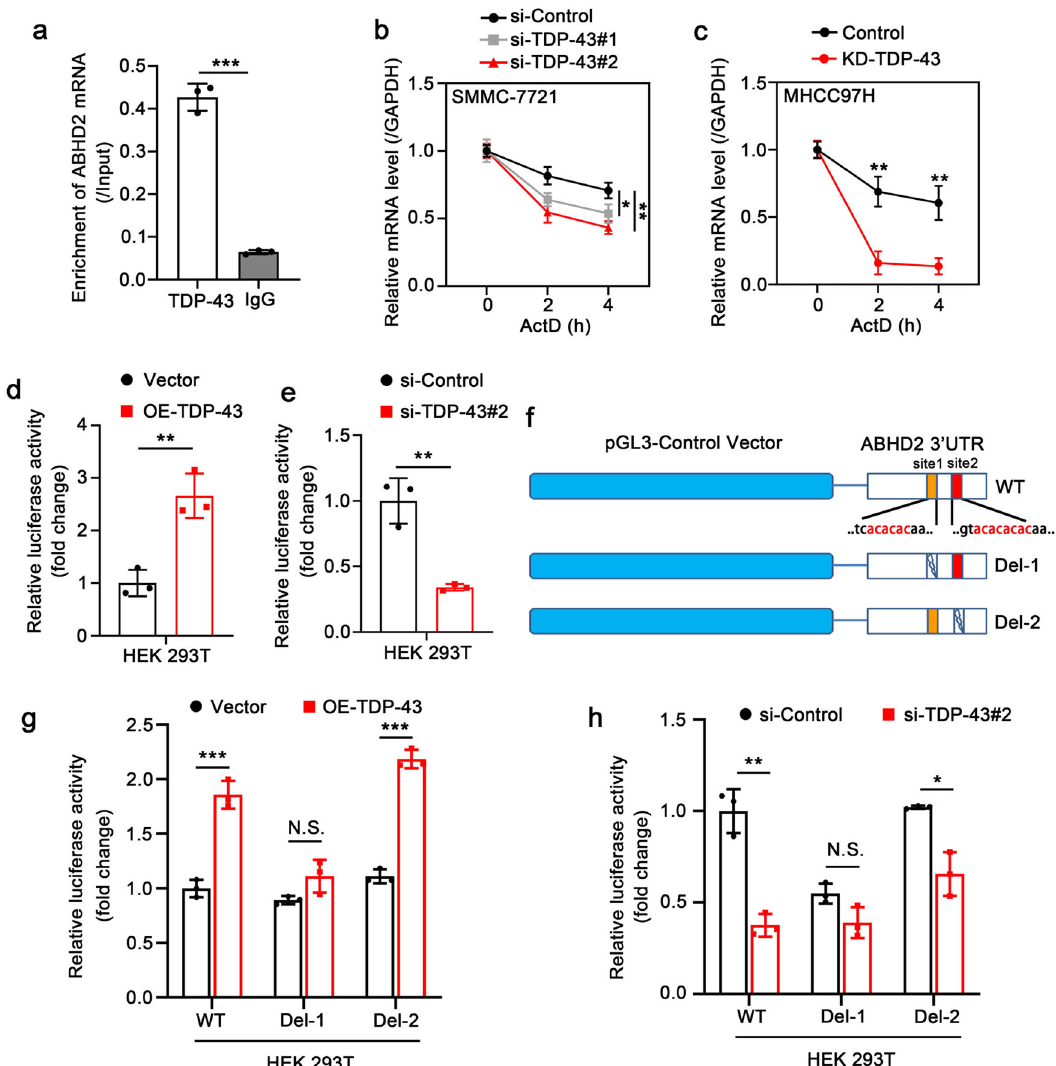
Fig. 5 TDP-43 upregulates ABHD2 through enhancing the mRNA stability of ABHD2. a RIP assay to detect the interaction between TDP-43 and ABHD2 mRNA in MHCC97H cells. The data was normalized to the Input. b The mRNA stability of ABHD2 was analyzed by qRT-PCR in SMMC-7721 cells upon TDP-43 deletion. The cells were treated with ActD for the indicated time points after transient transfection for the indicated siRNAs. c The mRNA stability of ABHD2 was analyzed by qRT-PCR in MHCC97H-KD-TDP-43 and MHCC97H-Control cells. The cells were treated with ActD for the indicated time points. Luciferase reporter gene assay of ABHD2 3 ʹ UTR activity upon TDP-43 overexpression ( d ) or knockdown ( e ). The cells were transiently transfected with the indicated plasmids or siRNAs. f Schematic representation of ABHD2 3 ʹ UTR constructed on pGL3-Control plasmid. WT represents the wild-type plasmid of ABHD2 3 ʹ UTR; Del-1 represents the WT plasmid without the binding site1 (UG-rich sequence1, 6704 – 6709 refer to NM_007011.8); Del-2 represents the WT plasmid without the binding site2 (UG-rich sequence2, 7122 – 7129 refer to NM_007011.8). Luciferase reporter gene assay of ABHD2 3 ʹ UTR activities upon TDP-43 overexpression ( g ) or knockdown ( h ). The HEK 293 T cells were transiently transfected with WT, Del-1 or Del-2 accompanied with the indicated plasmids or siRNAs. The values in the graphs represent the mean of three biologically independent experiments. Error bars represent ± s. d. * P < 0.05, ** P < 0.01, *** P < 0.001 by two-tailed Student ’ s t